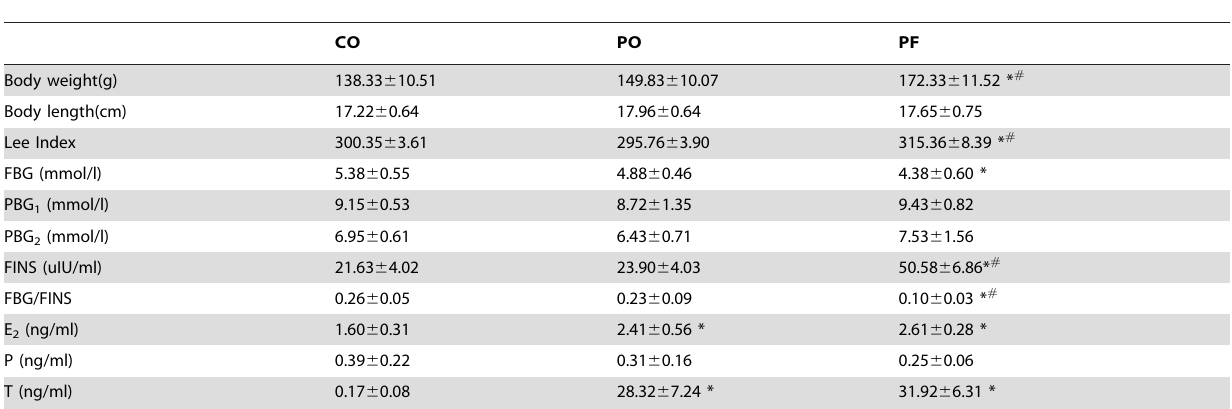
Table 1. Changes of metabolic and endocrine variables in obese PCOS model induced by high-fat diet.